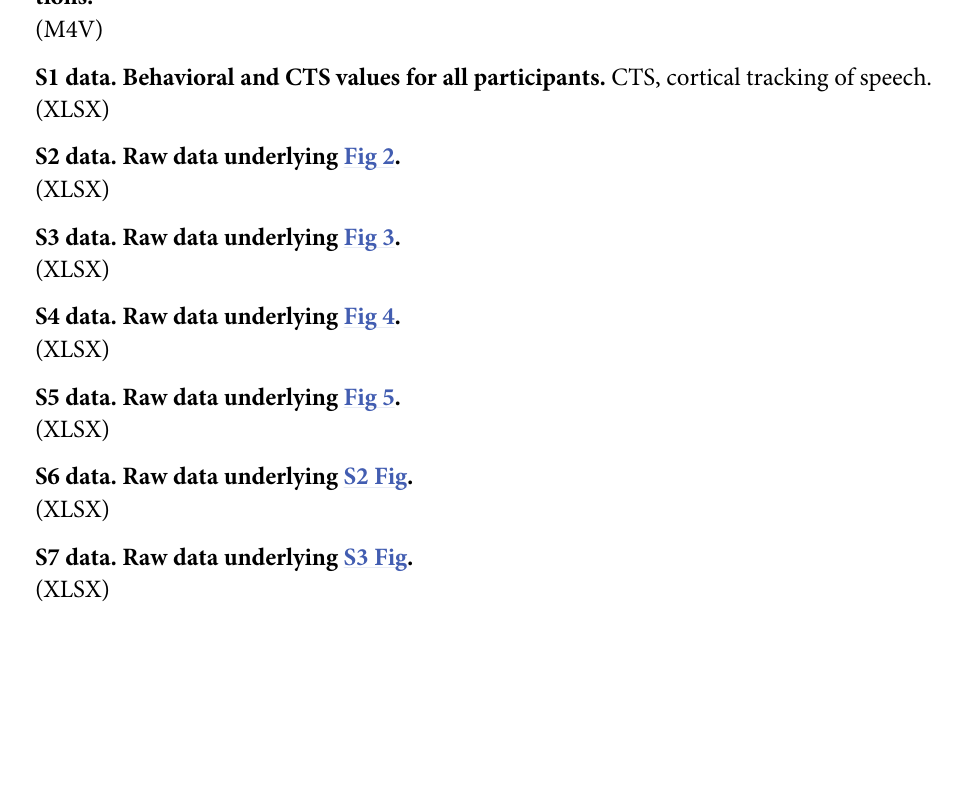
S8 Table. Pearson correlation between measures of reading abilities and relevant brain and behavioral measures in children with dyslexia. ��� p < 0.001, �� p < 0.01, � p < 0.05, # p < 0.1. nCTS, normalized cortical tracking of speech. (DOCX) S9 Table. Pearson correlation between measures of reading abilities and nCTS measures in children with dyslexia. ��� p < 0.001, �� p < 0.01, � p < 0.05, # p < 0.1. nCTS, normalized corti- cal tracking of speech. (DOCX) S1 Fig. Spectrogram of a 4-s excerpt of attended speech (A) and corresponding noise (B) in the range of 0–7 kHz. Wide-band spectrograms (0–20 kHz) are also presented for the attended speech and the least-energetic nonspeech noise (C) to show that noise power was confined to frequencies above 10 kHz in this latter noise condition. The zeros of the dBFS were fixed based on the attended speech spectrogram and applied to all noise spectrograms. dBFS, decibel full scale. (TIF) S2 Fig. Relation between reading abilities and the nCTS at phrasal rate in dyslexia. S6 Data contains the underlying data for this figure. nCTS, normalized cortical tracking of speech. (TIF) S3 Fig. Impact of the main fixed effects on the nCTS at phrasal (A) and syllabic rates (B) in children with dyslexia. All is as in Fig 2. S7 Data contains the underlying data for this figure. nCTS, normalized cortical tracking of speech. (TIF) S1 video. Exemplary video stimulus wherein static pictures were replaced by text descrip- tions. (M4V) S1 data. Behavioral and CTS values for all participants. CTS, cortical tracking of speech. (XLSX) S2 data. Raw data underlying Fig 2. (XLSX) S3 data. Raw data underlying Fig 3. (XLSX) S4 data. Raw data underlying Fig 4. (XLSX) S5 data. Raw data underlying Fig 5. (XLSX) S6 data. Raw data underlying S2 Fig. (XLSX) S7 data. Raw data underlying S3 Fig.